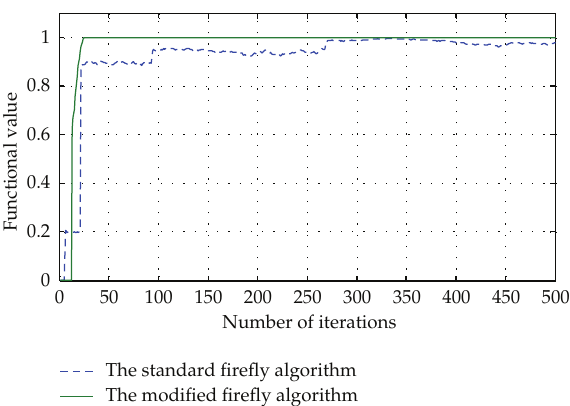
Figure 2: Simulation result of the second test